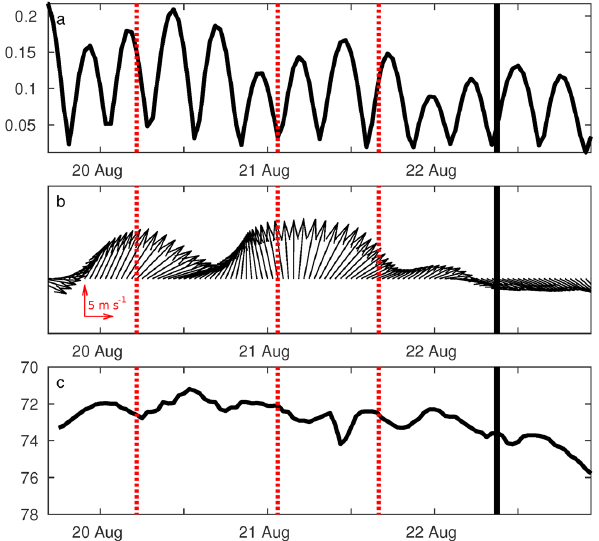
Figure 9. Tidal currents (ms − 1 , a ), 10m wind speed with scale ar- rows representing 5ms − 1 (b) , and depth (m, c ) at the Seaglider’s location during the survey. The dotted vertical lines indicate when vertical mixing events were evident. The vertical black line indi- cates the transition to a different water mass. Tidal data were ob- tained from the Tidal Model Driver (TMD) tide toolbox and OTIS (OSU (Oregon State University) Tidal Inversion Software) Euro- pean Shelf Model (Egbert et al., 2010). Wind data was obtained from ECMWF ERA-Interim reanalysis data. Bathymetry was gath- ered by the Seaglider’s on-board altimeter. The comparison was made by extracting data from the closest point in time and space to the glider’s location from the ECMWF 6-hourly high-resolution data. Linear interpolation was used in time between the ECMWF